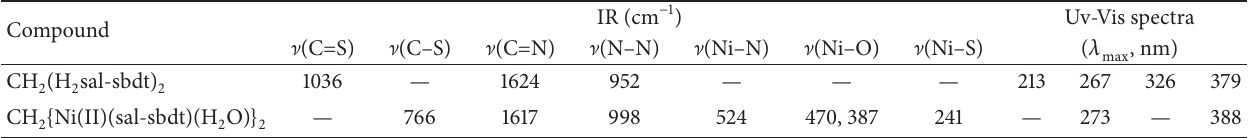
Table 2: IR and electronic spectral data of the ligand and title